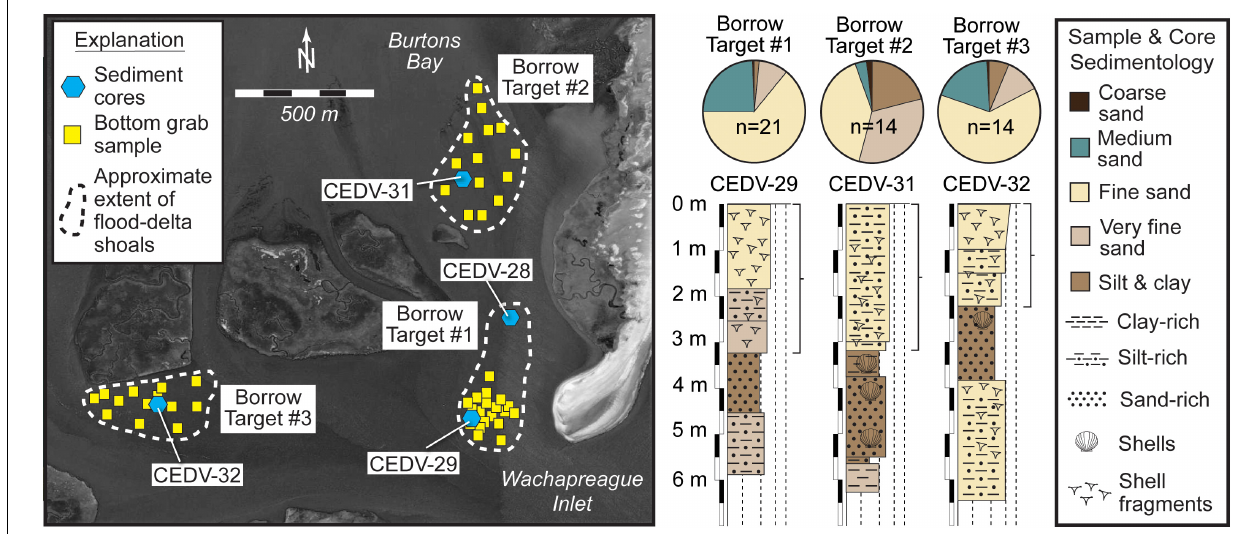
FIGURE 10 | Approximate extents and sedimentology of discrete flood-tidal delta shoals located along the margins of major inlet-proximal tidal channels, and identified as potential sand reservoir borrow sites for marsh construction project. Pie charts show average grain-size distributions of all samples collected within a given target borrow site (total number given as n value within chart). Brackets to the right of core logs indicate the thickness sediments appropriate for borrow for the marsh construction